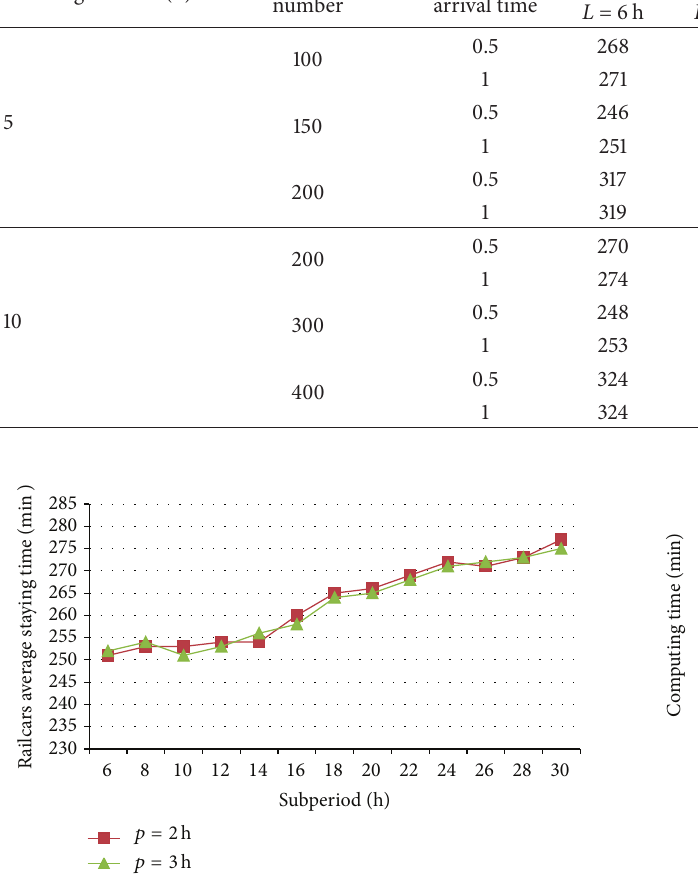
Table 4: The optimization results of different planning horizons and inbound train flows. Planning horizon (d)